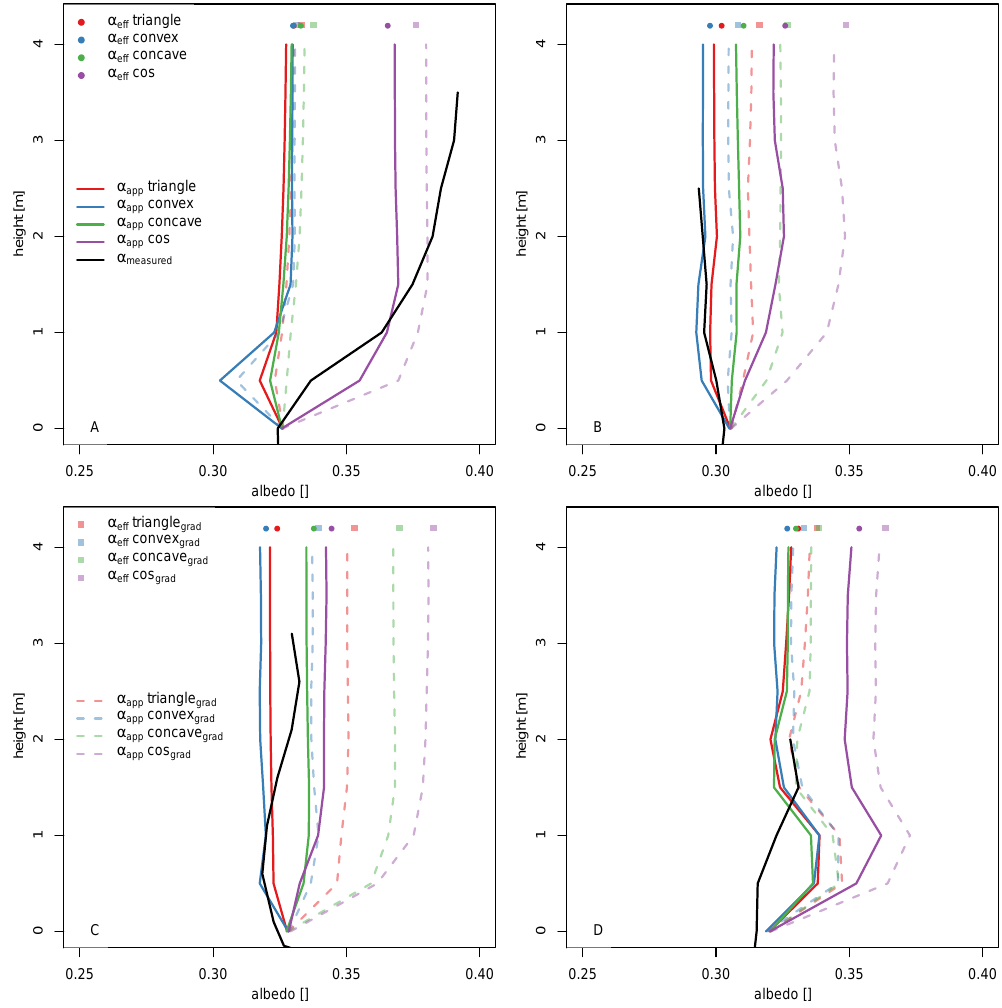
Figure 7. The measured and modeled (i.e., mean of 75 samples) albedo changes in function of height above the penitente surface. The dots/squares represent the effective albedo α eff of the penitente surface that is not height dependent. The lines illustrate the apparent albedo α app in function of the sensor height, where solid lines are used for a uniform material albedo and the dashed lines for a material albedo gradient within the